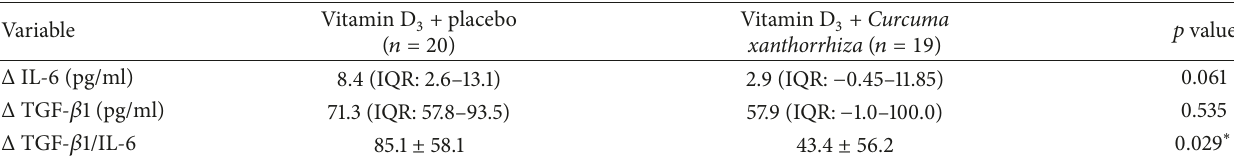
Table 4: Effects of C. xanthorrhiza supplementation on vitamin D 3 administration towards cytokine changes.